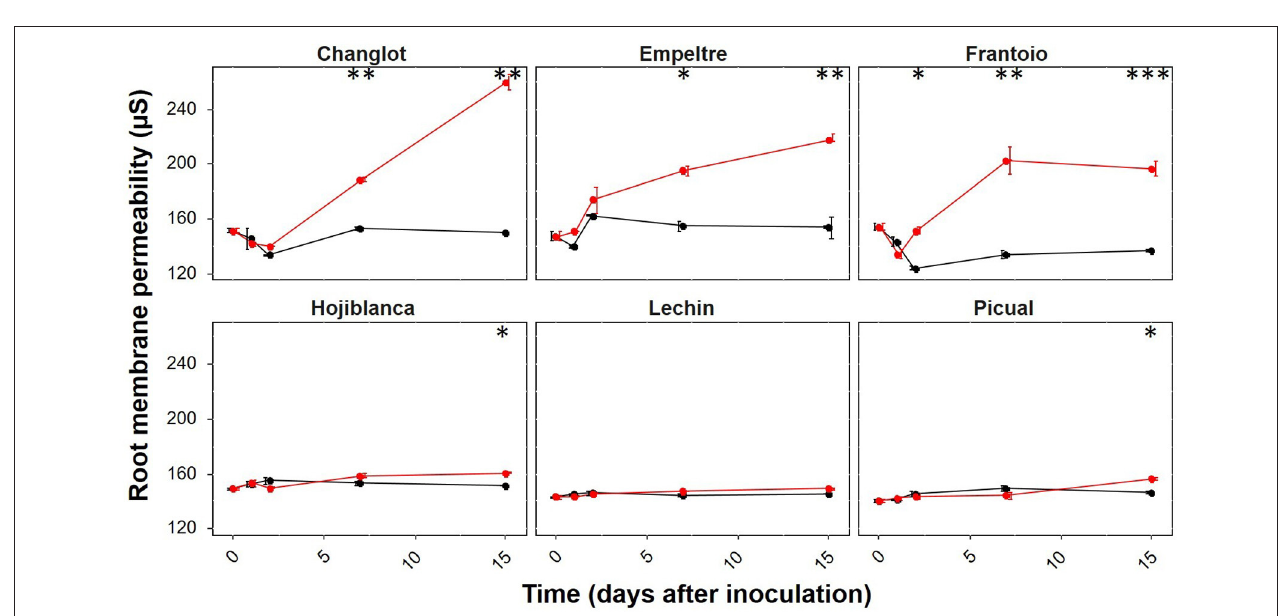
FIGURE 8 | Root membrane permeability of the six olive varieties tested along time after inoculation with Verticillium dahliae [0, 1, 2, 7, and 15 days after inoculation (DAI)]. Data are the average ( n = 3) for each sampling time. Non-inoculated plants are represented in black while V. dahliae -inoculated plants are in red. The error bars correspond to the standard deviation (SD) from the mean of the three replicates. Statistical differences at each time-point (ANOVA) between the control and inoculated plants are represented by asterisks (level of significance: *, p < 0.05; **, p < 0.01; ***, p <